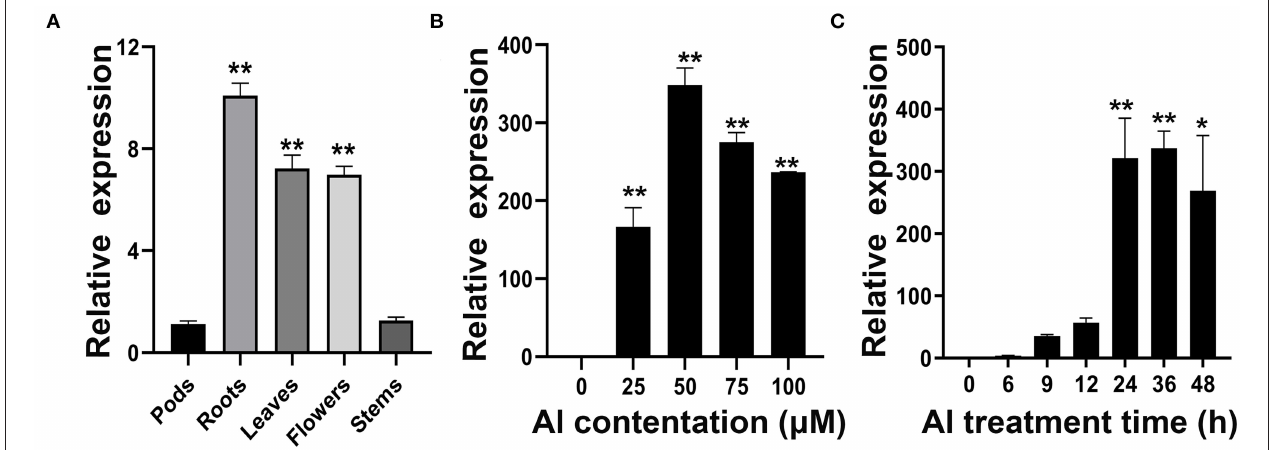
FIGURE 3 | Analysis of GmWRKY21 expression patterns in different tissues and in response to Al stress. (A) qRT-PCR analysis of the GmWRKY21 transcript in different tissues of the soybean variety Huaxia 3. The total RNA was isolated from the samples of soybean roots, stems, leaves, flowers, and pods. (B) Dose-dependent GmWRKY21 expression pattern in the roots of soybean seedlings. The root samples were taken from the seedlings exposed to different treatments of AlCl 3 concentrations (0, 25, 50, 75, and 100 µ M) for 24h. (C) The time-course GmWRKY21 expression pattern in the roots of soybean seedlings. The soybean seedlings were exposed to 50 µ M AlCl 3 for 0, 6, 9, 12, 24, 36, or 48h. The root samples were separately harvested for qRT-PCR analysis. The expressing values are designed as the means ± SEM ( n = 3). The experiments were performed with at least three independent biological replicates. Significant differences according to the one-way analysis of variance are denoted as follows: * P < 0.05 and ** P <